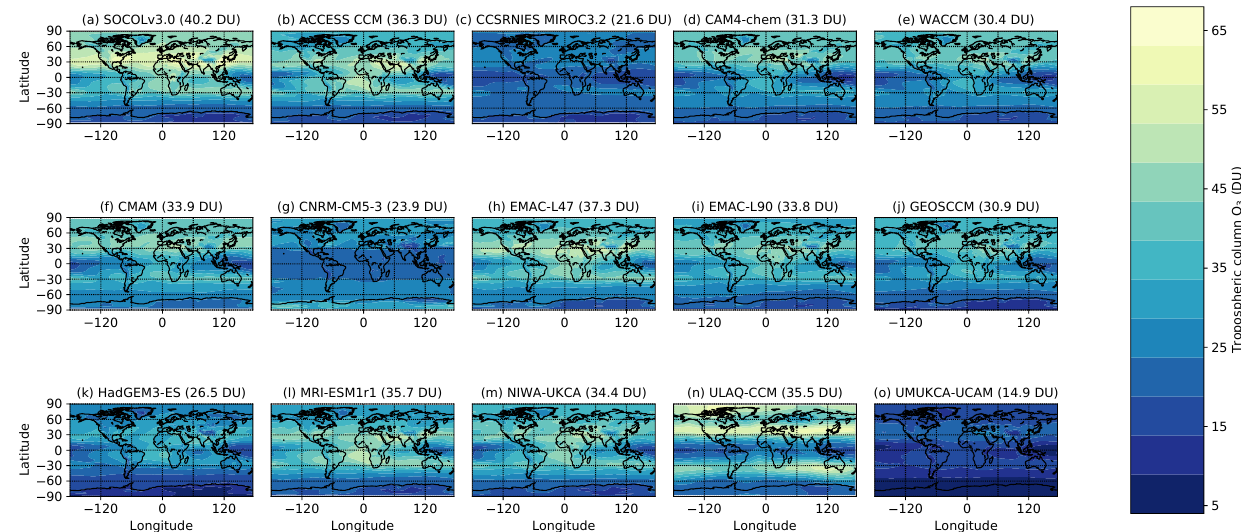
Figure 6. Annual-mean year 2005 tropospheric ozone columns in REF-C1 simulations from CCMI models (calculated relative to the WMO- defined tropopause pressure for each model). The global-mean tropospheric column ozone amount for each model is indicated in the title.